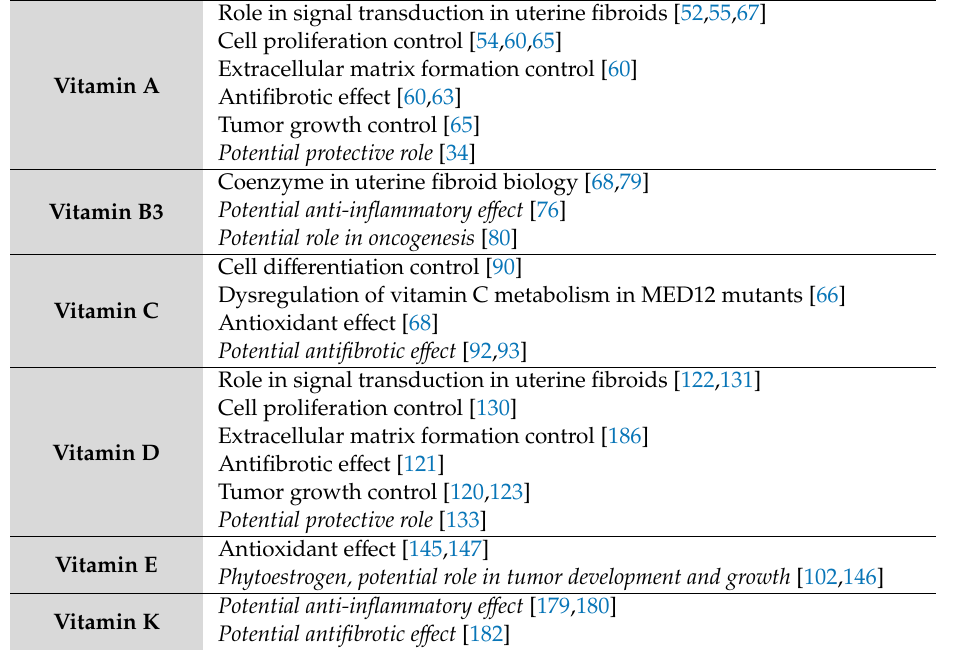
Table 1. The established and potential role of vitamins in uterine fibroids (the italics indicates possible role). Role in signal transduction in uterine fibroids